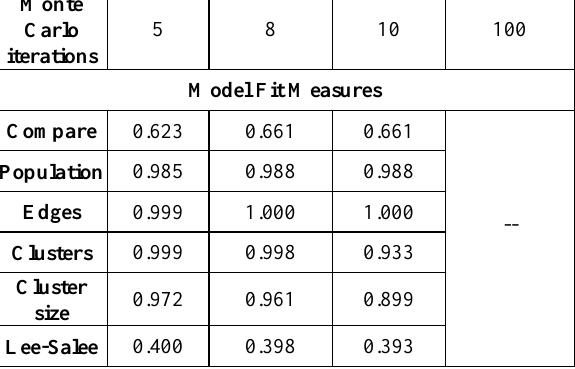
Table 9: Summary of calibration results and fit statistics